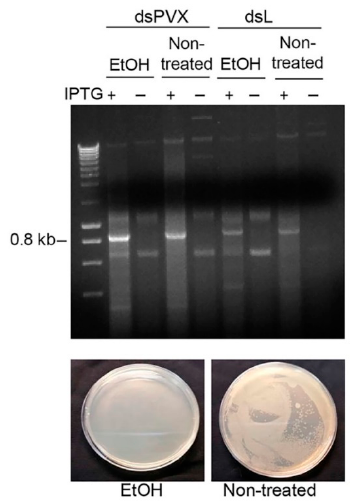
Figure 2. Production of Potato virus X (PVX) dsRNA in an E. coli strain deficient for RNase III. HT115(DE3) was transformed with either L4440 expressing a dsRNA consisting of 819 bp of the PVX CP gene (dsPVX) or with the empty plasmid (dsL). Bacterial cultures induced with IPTG were non-treated or treated with ethanol 70%, and processed for total nucleic acid. Samples were resolved by electrophoresis on 1% agarose gel. NZYDNA Ladder III was used as DNA markers. Bacterial cells were plated on LB agar for testing survival (bottom panels).